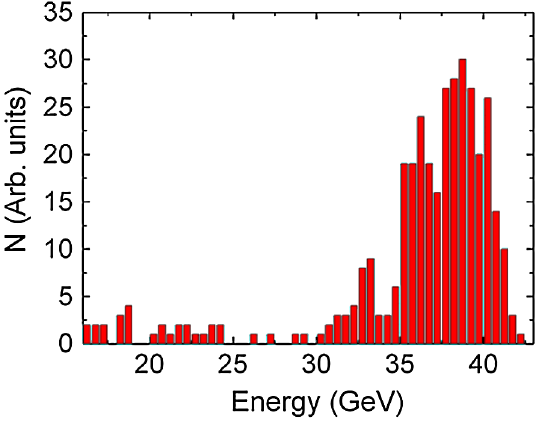
FIG. 2. (Color) Energy spectrum of protons from the simulation at t ¼ 800 T